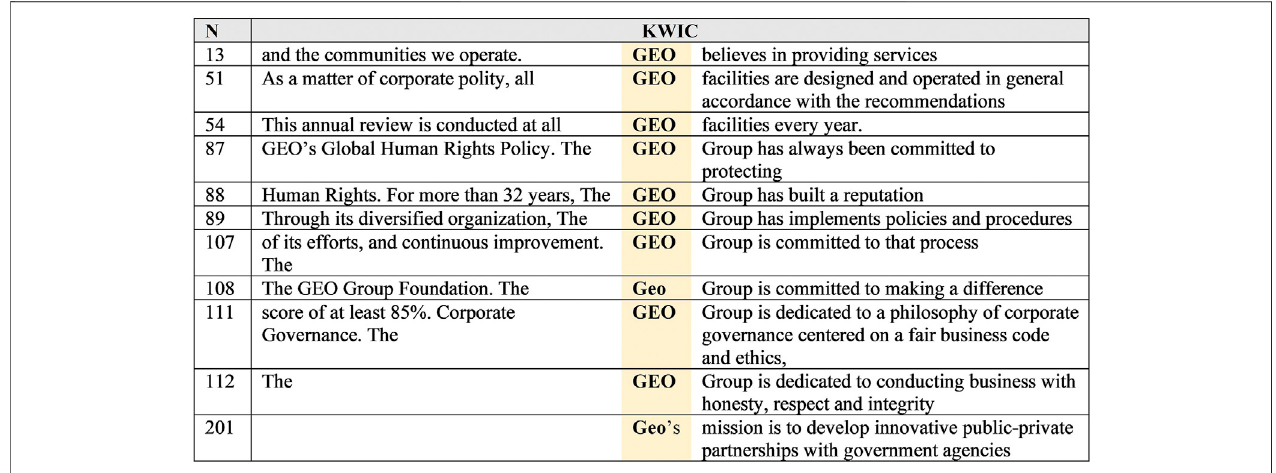
FIGURE 6 | The GEO corpus, “ GEO ” concordance lines (10 out of